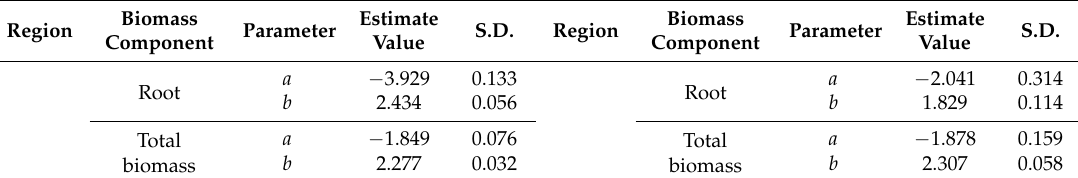
Table 7. Evaluation statistics of the general model, dummy variable model, mixed effects model, and Bayesian hierarchical model for biomass modeling.